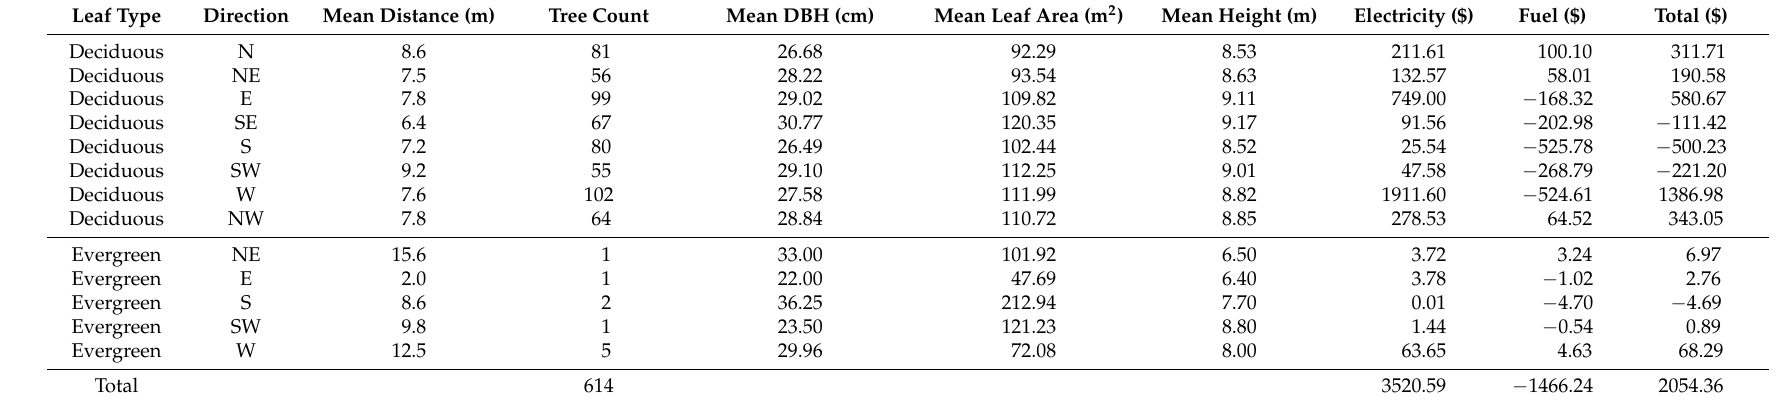
Table 8. Annual energy savings and monetary values provided by street trees in Kyoto